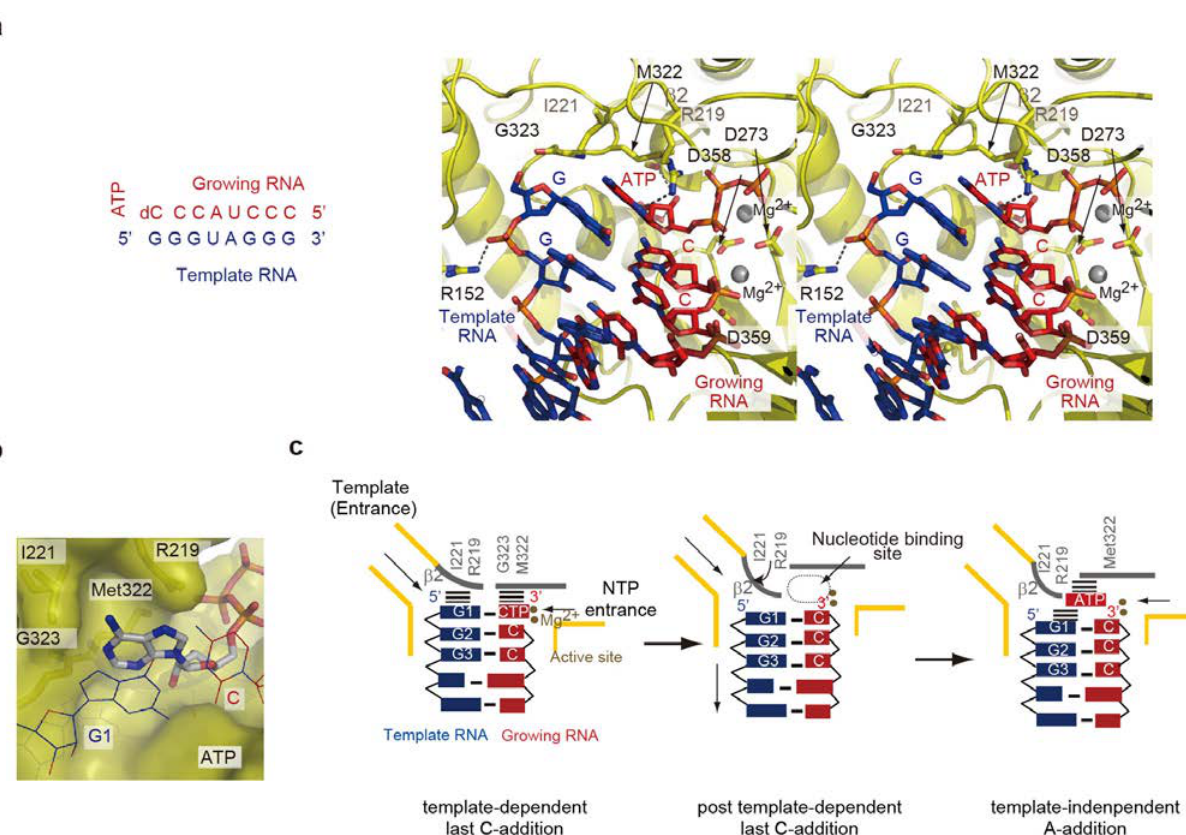
Figure 6. Structures of termination stages. ( a ) Structure of terminal RNA adenylation at the final stage of RNA polymerization by the core Qβ replicase. Only the structure of the catalytic crevasse of the core Qβ replicase is shown. The sequences of the template and growing RNAs are depicted. The template RNA, the growing RNA and ATP are depicted by stick models; ( b ) The size and shape of the pocket are suitable for ATP accommodation; ( c ) Simplified depiction of the structure representing post template-dependent last C -addition ( left ) and non-template 3'-A addition ( right ) by the core Qβ replicase. After the last C -addition in a template-dependent manner, the double stranded RNA of the template and growing RNAs translocates, and the β2 region changes its conformation and participates in the ATP